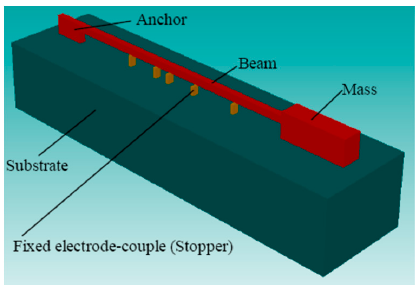
Figure 5. A multiple-contact switch based on a single electrostatically driven cantilever [22].